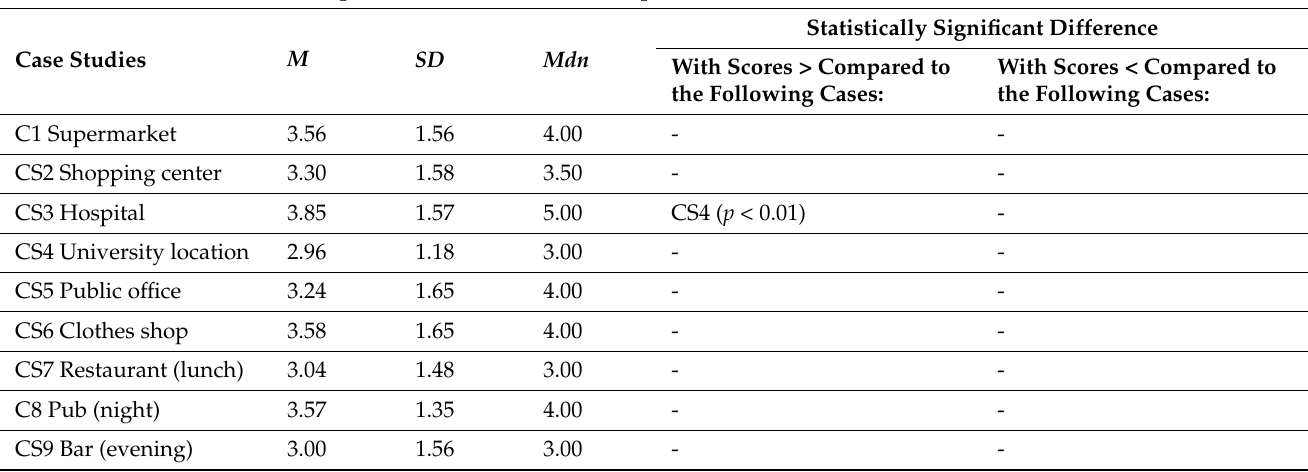
comparison of item 17 in the different case studies (CS1–CS9). In the table are also reported the